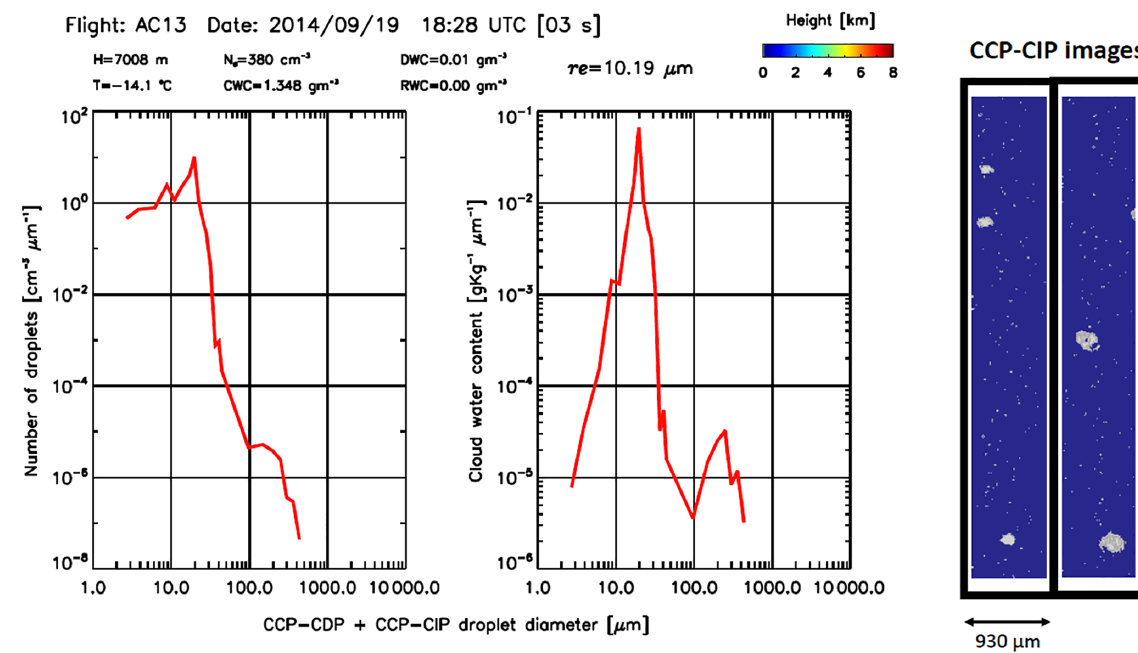
Figure 14. Similar to Fig. 5a–c for flight AC13.